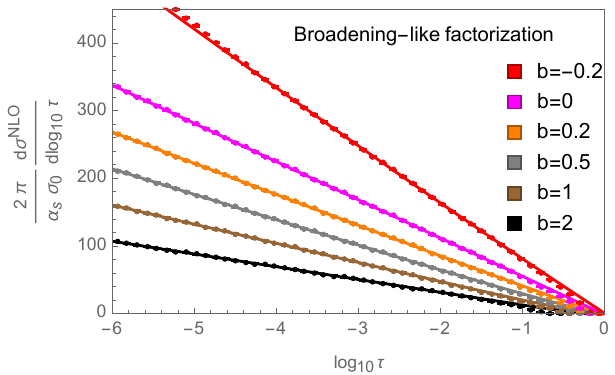
Figure 4 . Normalized one-loop angularity cross sections from Event2 against our analytic one-loop results based on broadening-like factorization for a variety of exponents.